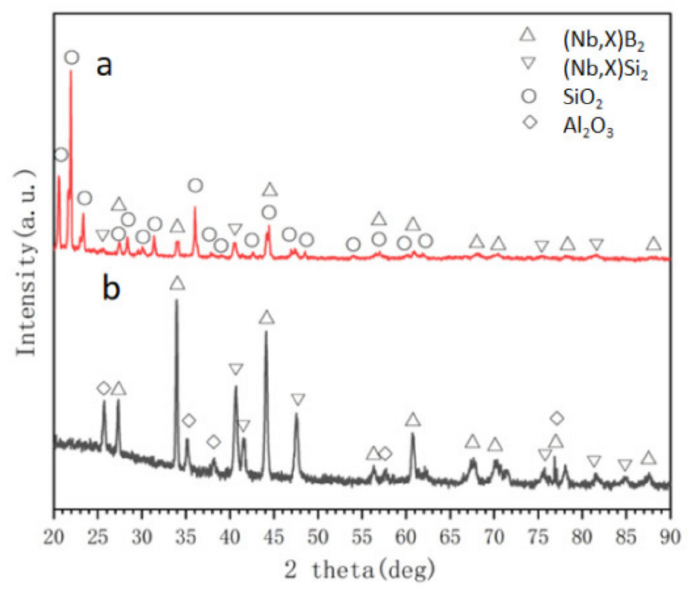
Figure 1. X-ray patterns of B modified silicides coatings prepared with Al 2 O 3 ( a ) and SiO 2 ( b ).